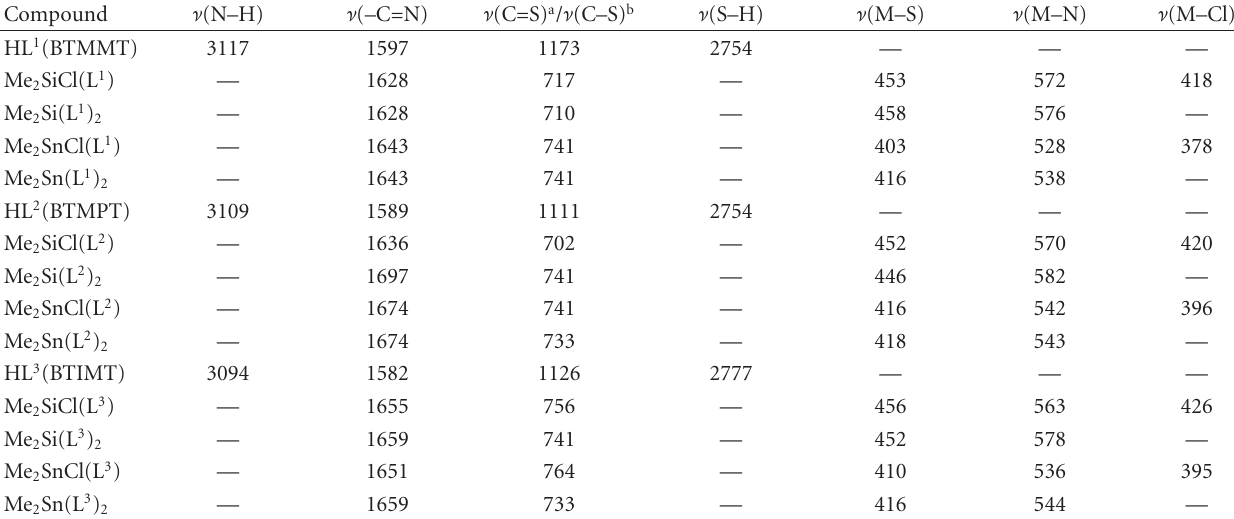
Table 2: IR-spectroscopic data (cm − 1 ) of the ligands and their metal complexes.